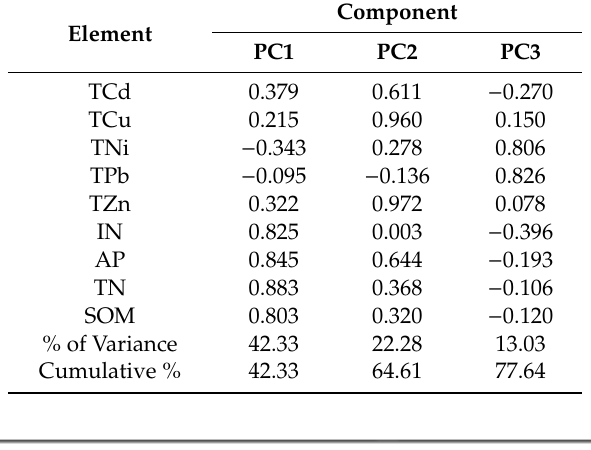
Table 3. The results of the principal component analysis.